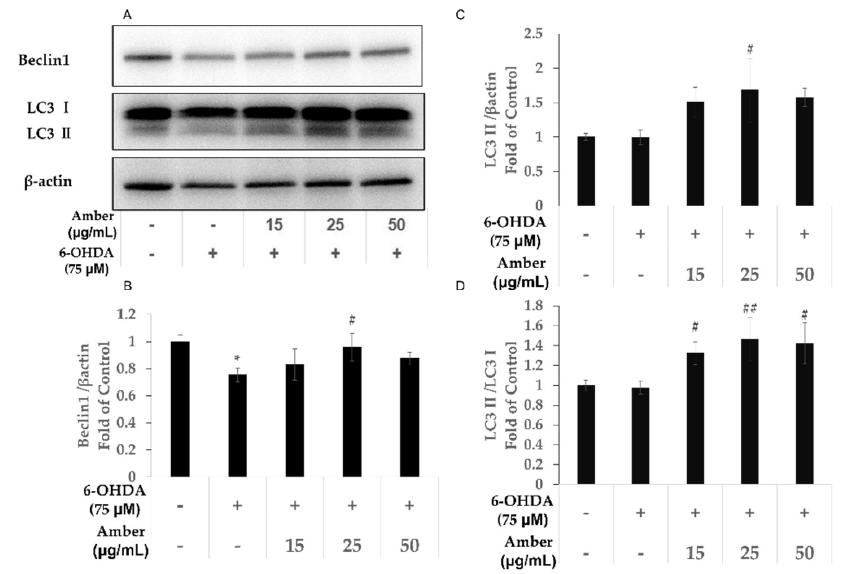
Figure 4. Effect of amber extract on autophagy-related gene expression: SH-SY5Y cells were cultured in DMEM/F12 medium with 10% FBS. After 24 h of seeding, the cells were pretreated with amber extract for 24 h, and then the medium was replaced with fresh 6OHDA-containing medium for another 24 h. Control (Ct): (6-OHDA/amber) −/−, 6-OHDA: (6-OHDA/amber) +/−, Amber: (6-OHDA/amber) (+/15 μg/mL; +/25 μg/mL, +/50 μg/mL) ( A ) Representative Western blot image of Beclin-1 and LC3. ( B ) The protein bands of Beclin-1 were quantified using ImageJ. ( C ) The protein bands of LC3 Ⅱ were quantified using ImageJ. ( D ) The relative ratios of LC3 II/LC3 I bands’ density. The results are expressed as the mean ± standard deviation. n ≥ 3 * p < 0.05 vs. Control, # p < 0.05 vs. 6-OHDA, ## p < 0.01 vs. 6-OHDA.